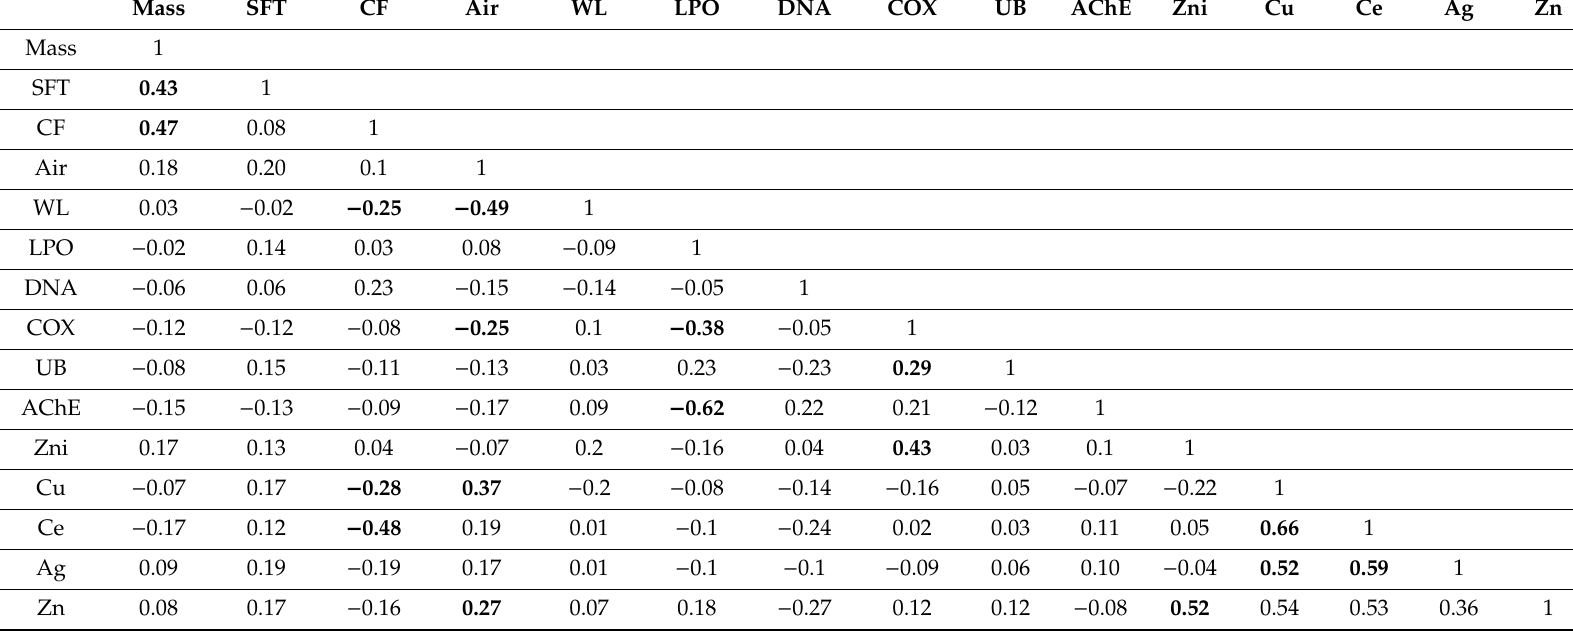
Table 3. Correlation analysis of biomarker